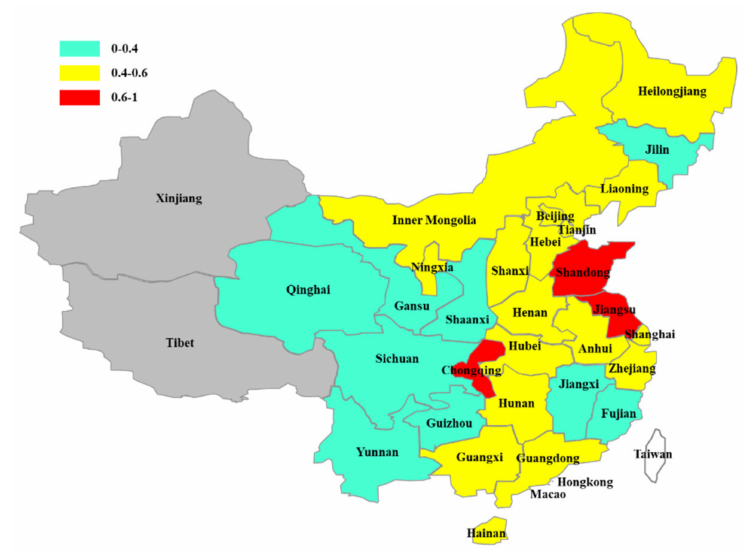
Figure 3. Urban relative poverty rate of provinces and cities in